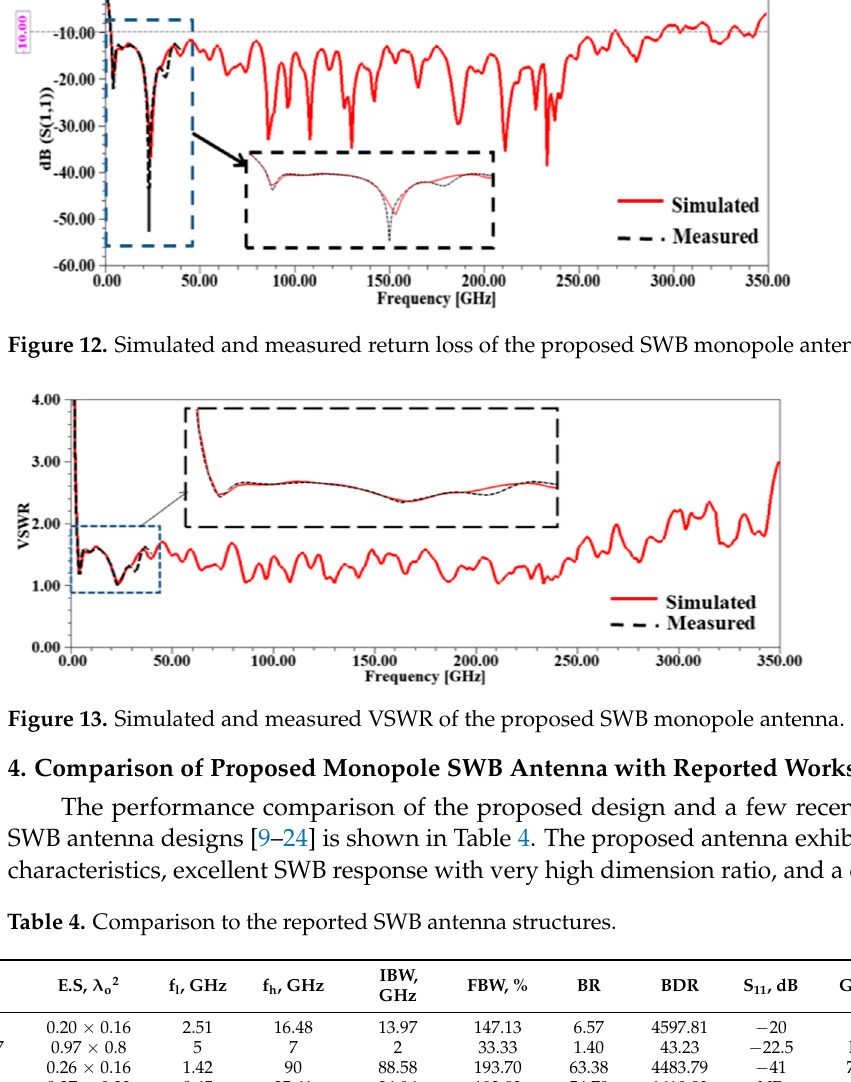
Figure 11. Fabricated prototype: ( a ) front view, ( b ) rear view.